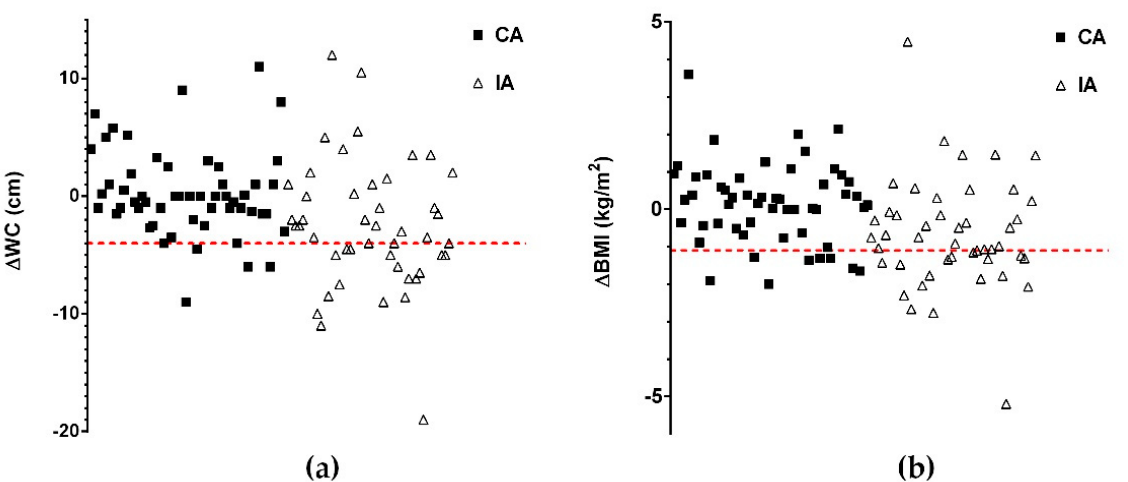
Figure 2. Waist circumference variation ( ∆ WC) and BMI ( ∆ BMI) in the control arm (CA) and intervention arm (IA) at the end of the 24 months of the intervention program. ( a ) ∆ WC and ( b ) ∆ BMI were calculated as the difference between the value measured at T24 and the baseline value. The dashed red lines ( ∆ WC = − 4 cm and ∆ BMI = − 1.11 kg/m 2 ) show the cutoffs between the two arms, which were mathematically corresponding to the 25th percentile of the whole data distribution. Each square represents a single patient from the CA and each triangle represents a single patient from the IA.